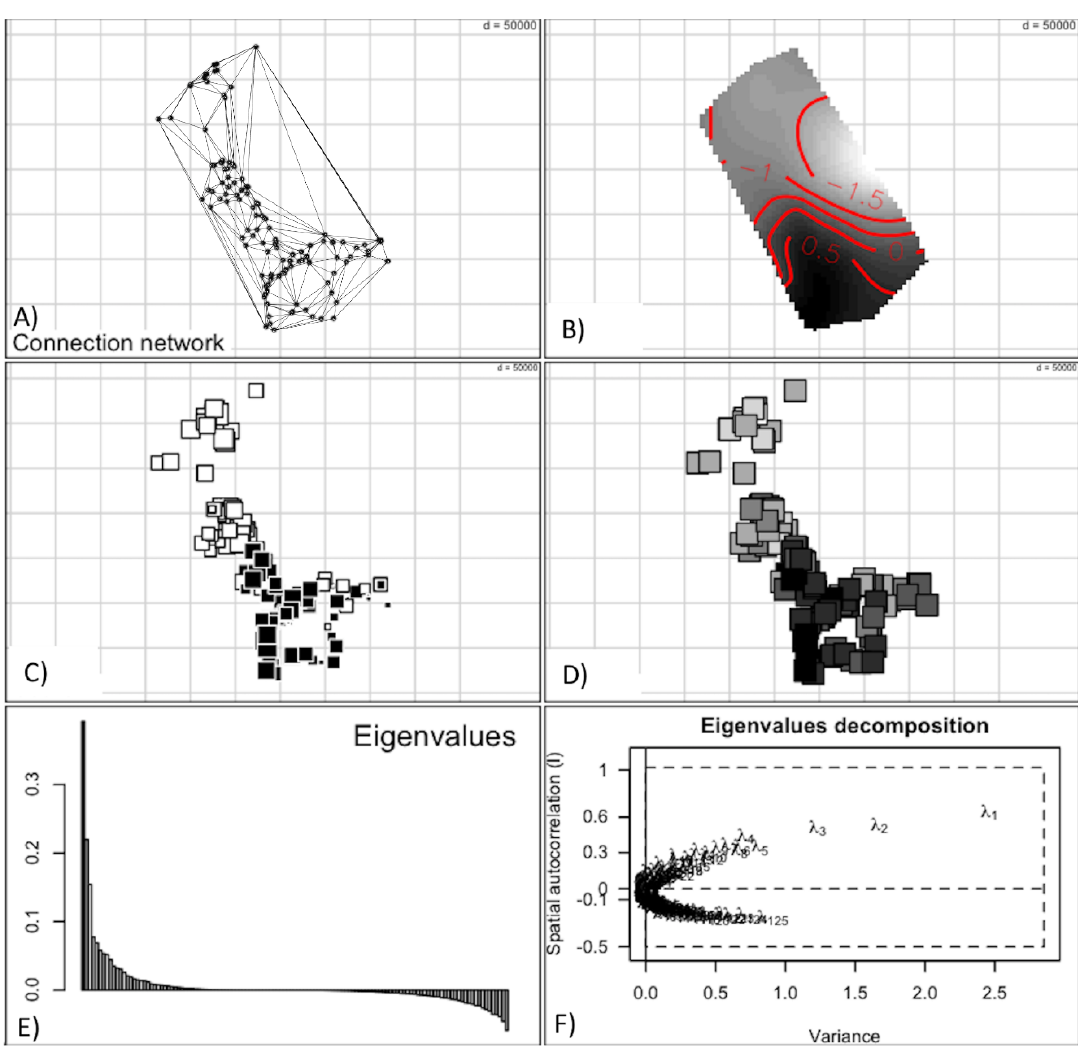
Figure A1.3 Spatial Principal Components Analysis of grizzly bear population structure for male and female bears conducted with a A) Delauney Connection Network and producing B-D) three representations of the first score and E-F) two eigenvalue